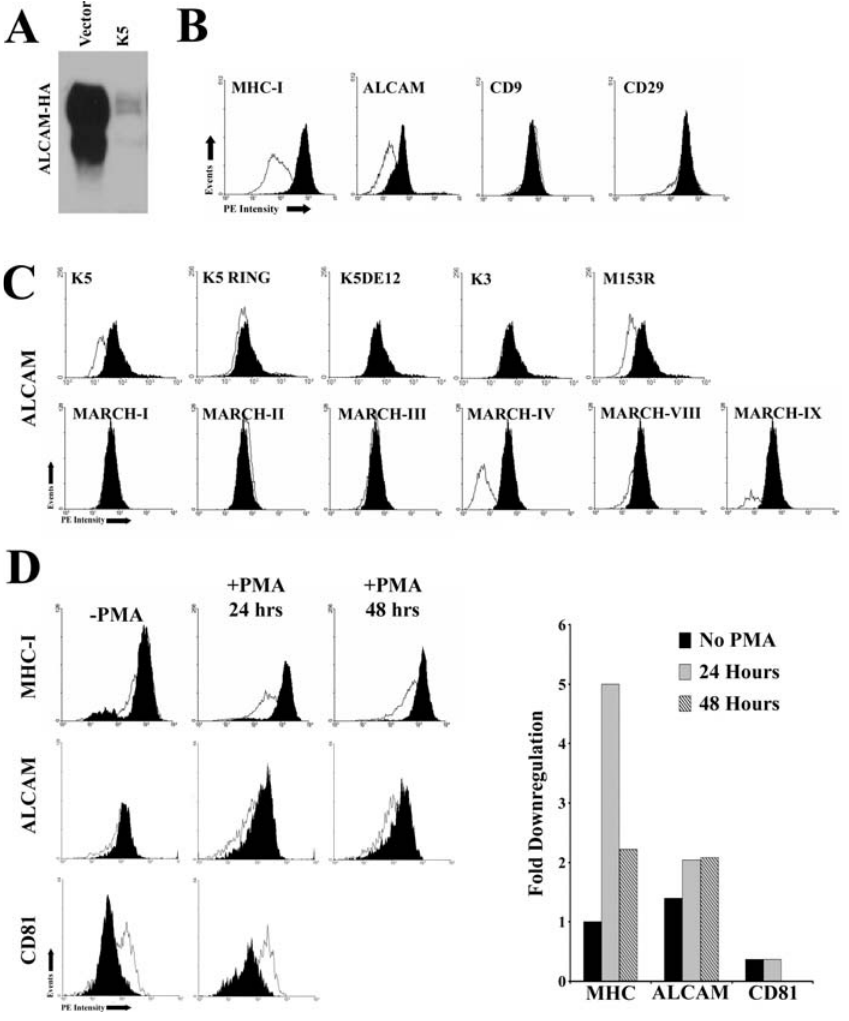
Figure 5. K5 Downregulates ALCAM (A) C-terminally HA-tagged ALCAM was co-transfected with K5 or control plasmid. Then 24 h post-transfection, cells were harvested and the abundance of ALCAM-HA in each lysate was measured by Western blotting with anti-HA antibody. (B) Cell surface expression of endogenous ALCAM in the presence or absence of K5 was determined by flow cytometry. HeLa cells were co-transfected with K5 and a green fluorescent protein (GFP)–expressing plasmid to identify transfectants. Then 24 h post-transfection, cells were harvested and stained with antibodies against MHC I, ALCAM, CD9, and CD29. Both vector (solid black) and K5-transfected (white) cells were gated for GFP-expressing cells. (C) ALCAM downregulation by K5-related proteins was determined by transfecting HeLa cells with viral K3 family members (K3 and M153R) and the indicated human MARCH proteins. Also examined were mutant K5 proteins with enzymatically inactive RING-CH domains (K5-RING) or lacking acidic residues implicated in subcellular targeting (K5DE12). Neither K5 mutant reduced ALCAM levels. KSHV K3 was unable to downregulate ALCAM, whereas the myxomavirus M153R protein significantly reduced ALCAM surface expression. Two of the MARCH proteins, MARCH-IV and MARCH-IX, strongly downregulated ALCAM, while MARCH-VIII showed a minimal effect. (D) To determine whether ALCAM expression was affected by KSHV, latently infected immortalized DMVECs were treated with PMA to induce expression of lytic genes including K5. Surface levels of either MHC I or ALCAM were measured by flow cytometry 24 and 48 h post-induction. CD81, measured at 24 h, was used as a control. The ratio between the mean fluorescence intensity of infected and uninfected samples from these experiments is shown as fold change on the right. DOI: